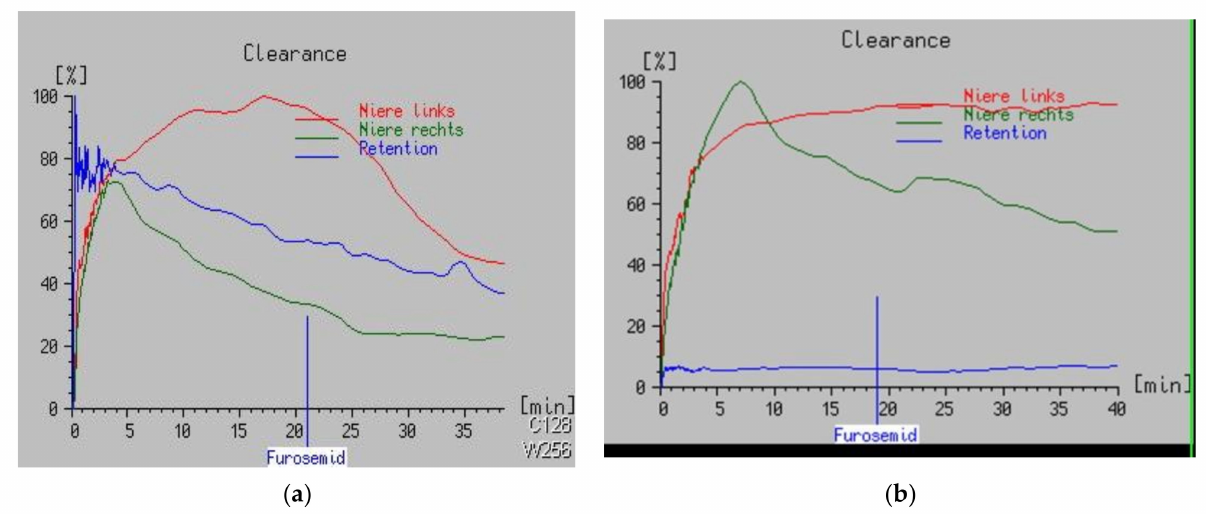
Figure 2. ( a ) In the kidney scintigraphy test, a retention kidney on the left side with borderline reaction on furosemide stimulation and excretion half-time of 17:39 min implicated a ureteropelvic junction obstruction (UPJO) (18 June 2020). Norm values: normal < 10 min, suspicious 10–20 min, abnormal > 20 min (courtesy of Dr. P. Zimmer, Klinikum Esslingen). ( b ) Repeated kidney scintigraphy test, constant retention kidney on the left side. Minor reduction of urinary clearence (left side 40%, right side 60%) (5 November 2020). Indication for surgery (courtesy of Dr. P. Zimmer, Klinikum